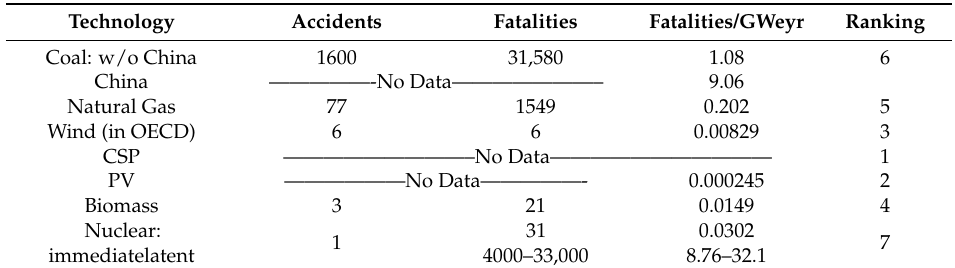
Table 4. Risk assessment data of energy systems in non-Organisation for Economic Co-operation and Development (non-OECD) countries [71].